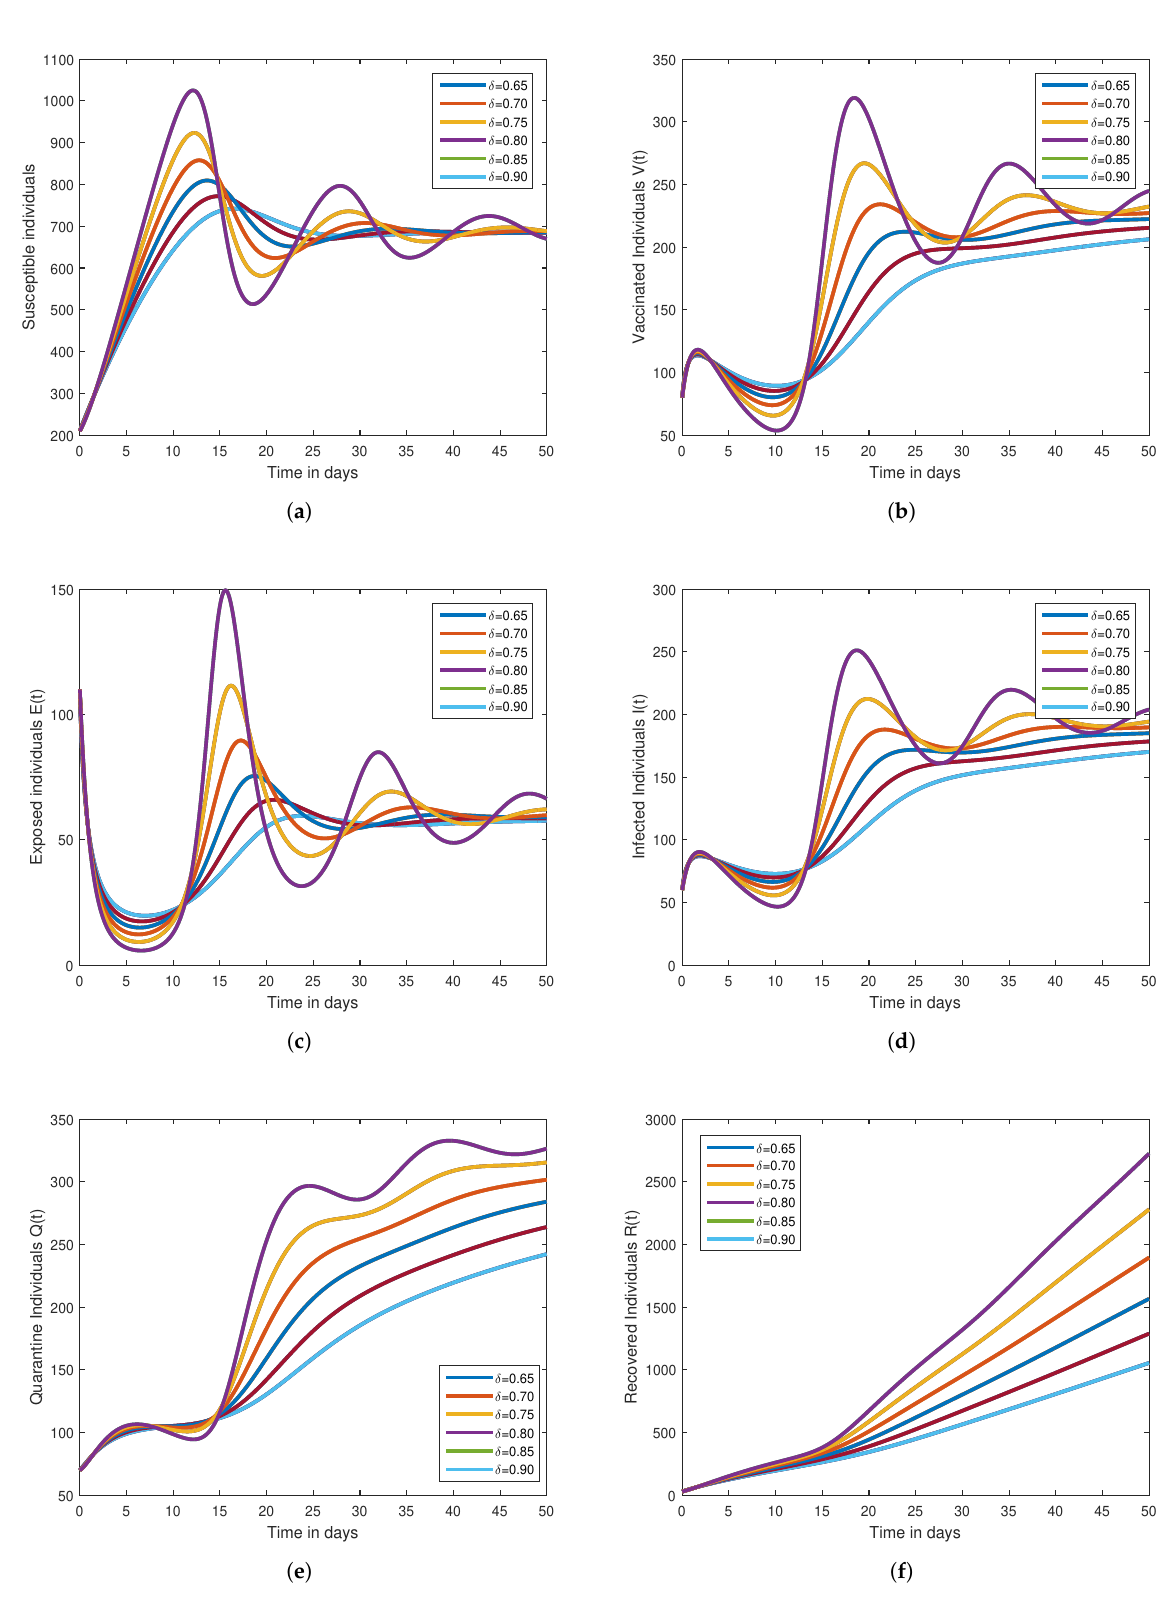
Figure 6. The behavior of each state variable for the Caputo fractional model utilizing a different set of initial conditions is depicted in the figure. Furthermore, the figures ( a – f ) represents susceptible people S ( t ) , vaccinated people V ( t ) , exposed people E ( t ) , infectious people I ( t ) , quarantined people Q ( t ) , and recovered people R ( t )